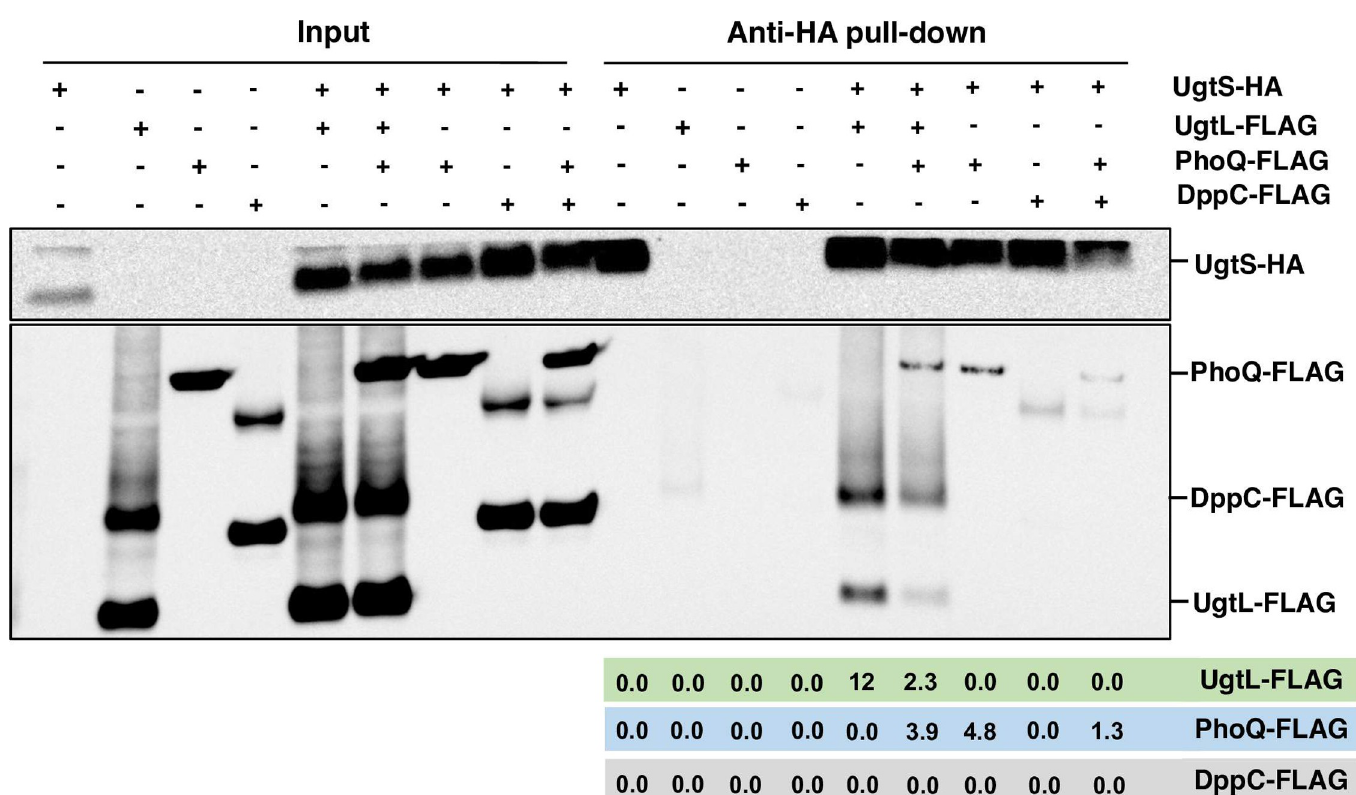
Fig 5. UgtS interacts with the UgtL and PhoQ proteins. Anti-HA pull-down assay showing interactions between in vitro –synthesized UgtS-HA, UgtL-FLAG, PhoQ-FLAG, and DppC-FLAG proteins. Samples were analyzed by Western blotting using antibodies recognizing the HA or FLAG epitopes. Numbers under the anti-HA pull-down portion of the blot indicate the protein amounts in arbitrary units of the pulled-down FLAG-tagged proteins. Data are representative of three independent experiments, which gave similar results.